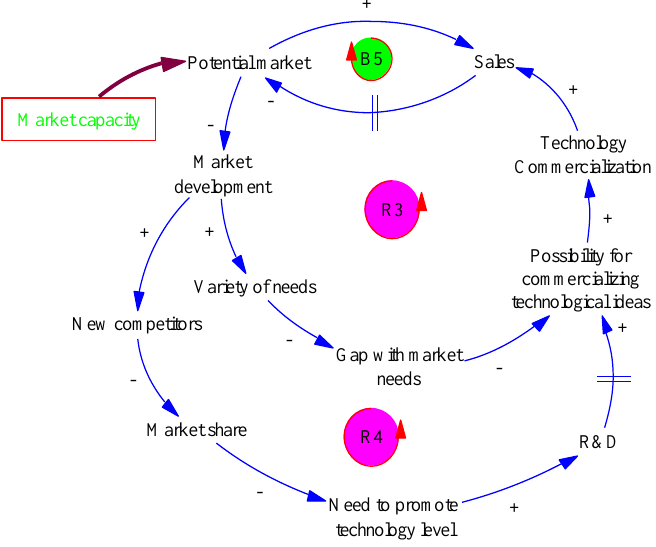
Figure 7. Market development loop and utilizing technological